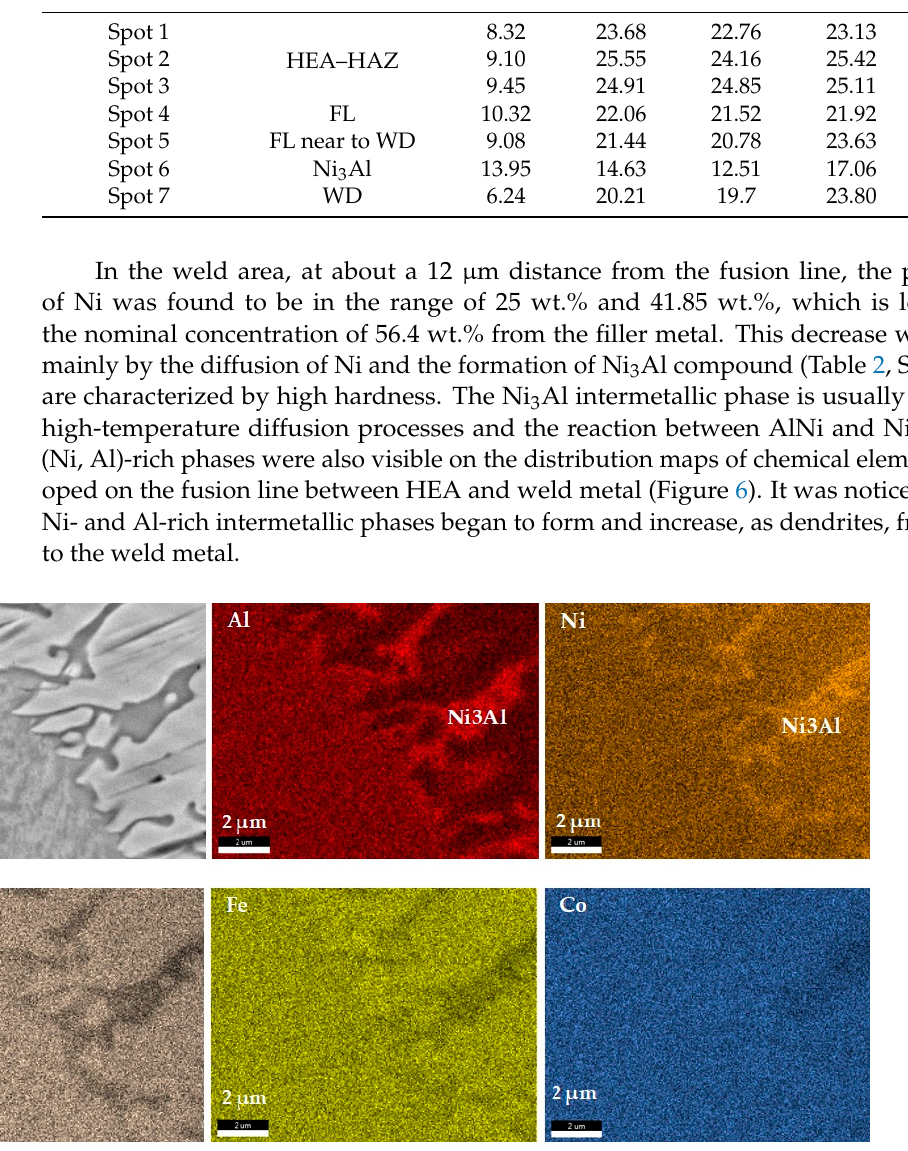
Table 2. Chemical composition measured in different spots, corresponding to Figure 4b. Measuring Spot Measuring Zone Chemical Element Concentration, wt.%